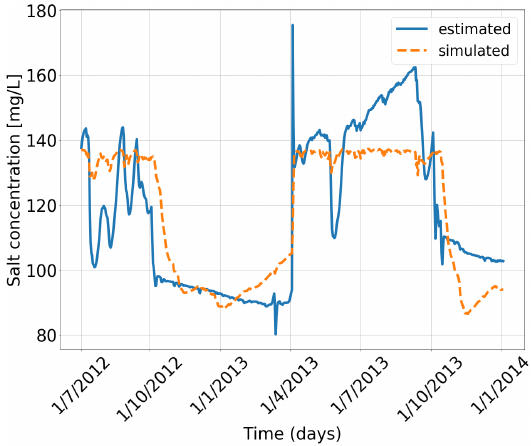
Figure 9. Performance of the sensor placement at node 51.